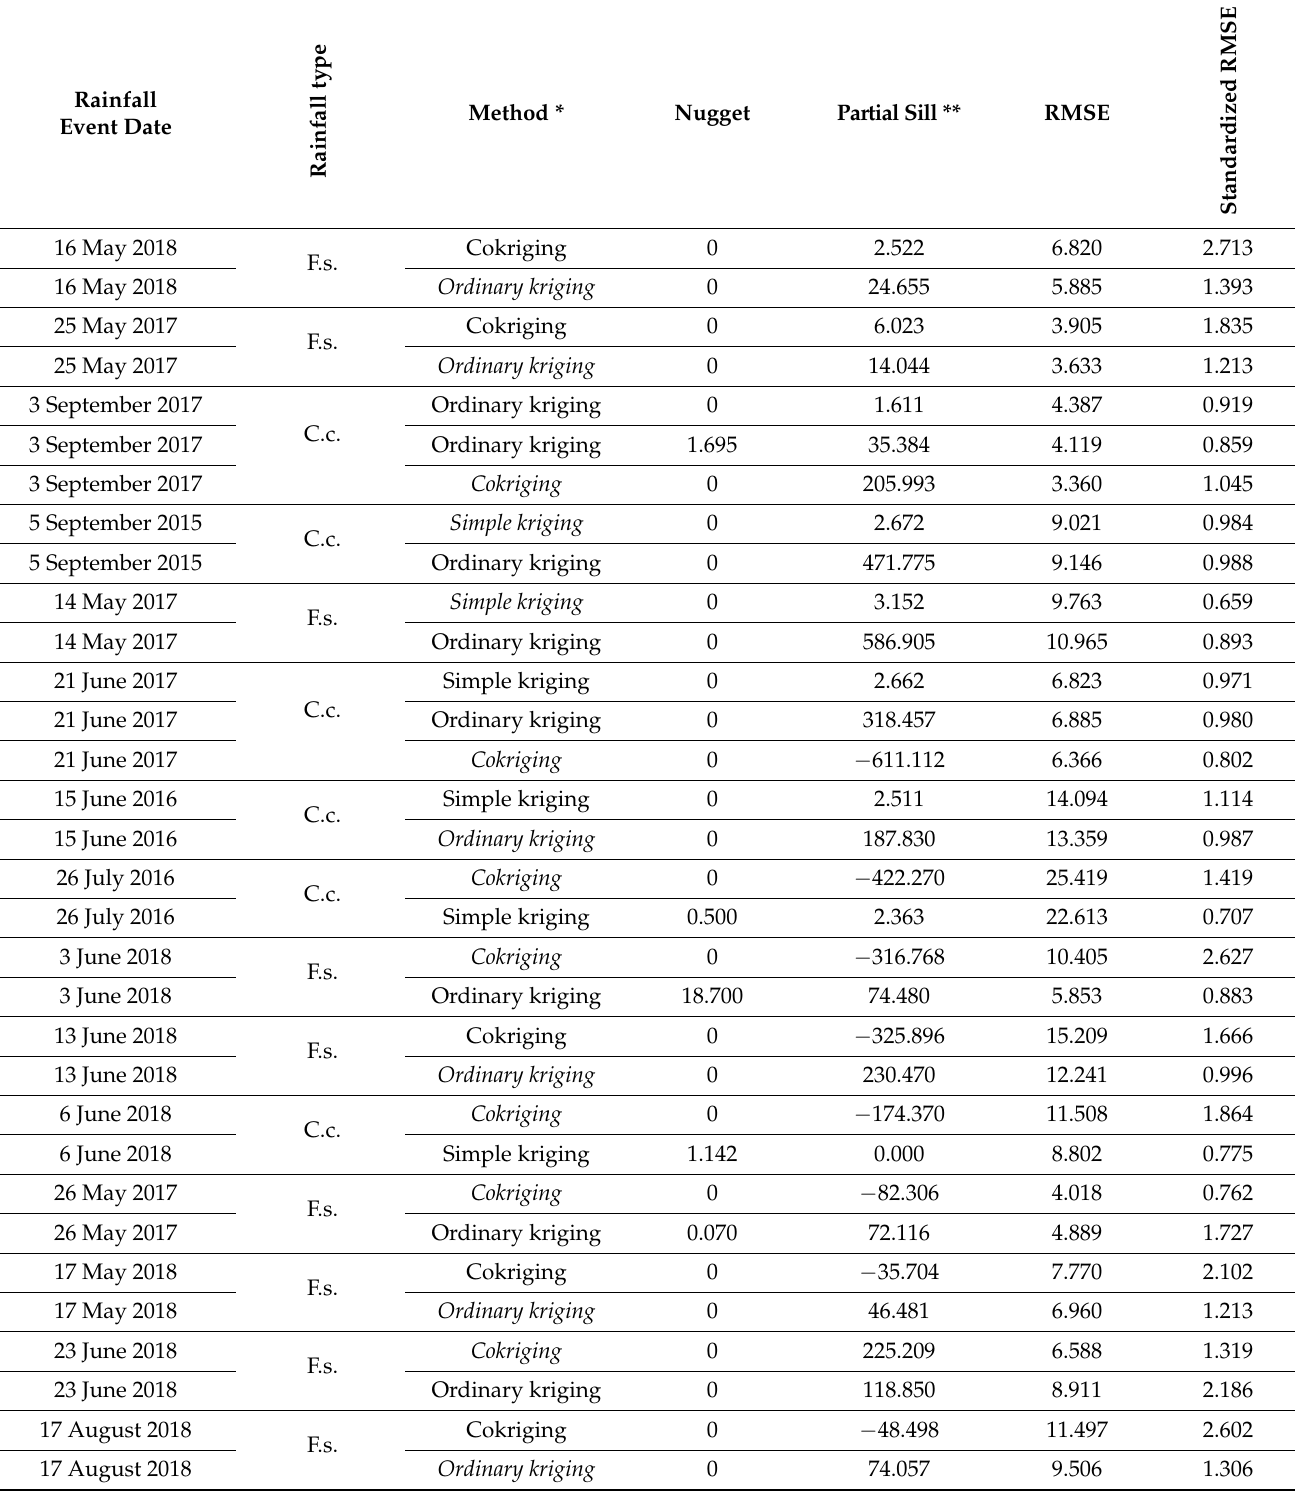
Table 3. Interpolation tests